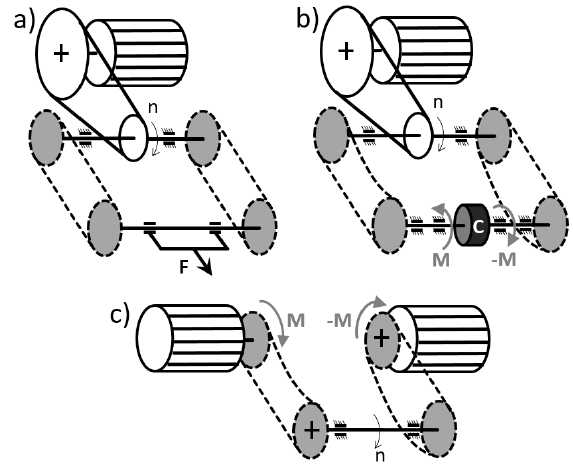
Figure 4. Tensioning methods on-chain test benches The advantage of component benches is